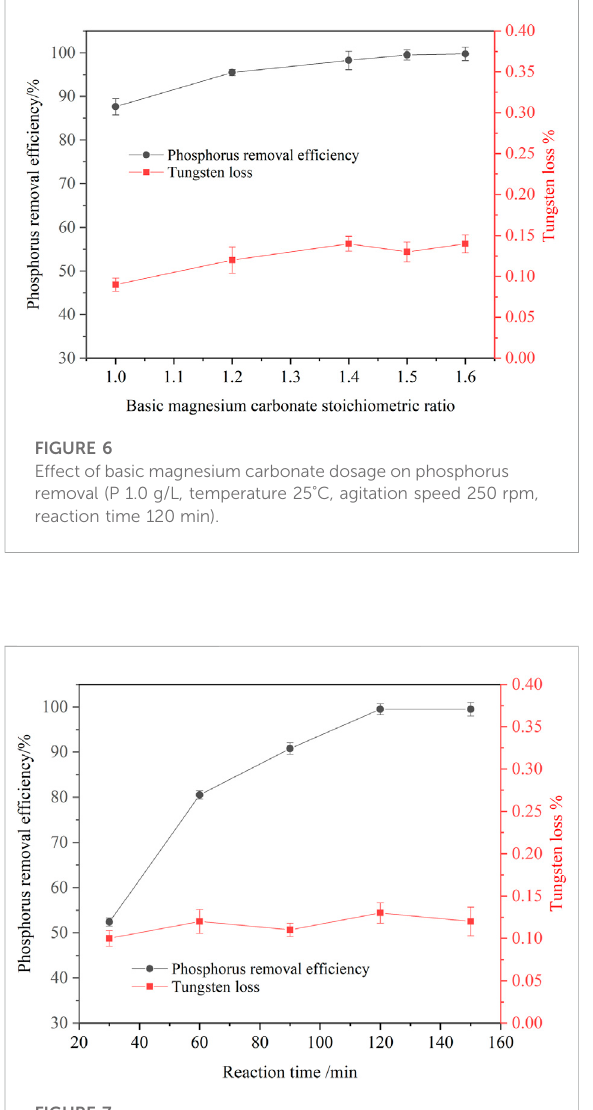
FIGURE 9 Effect of temperature on phosphorus removal (P 1.0 g/L,